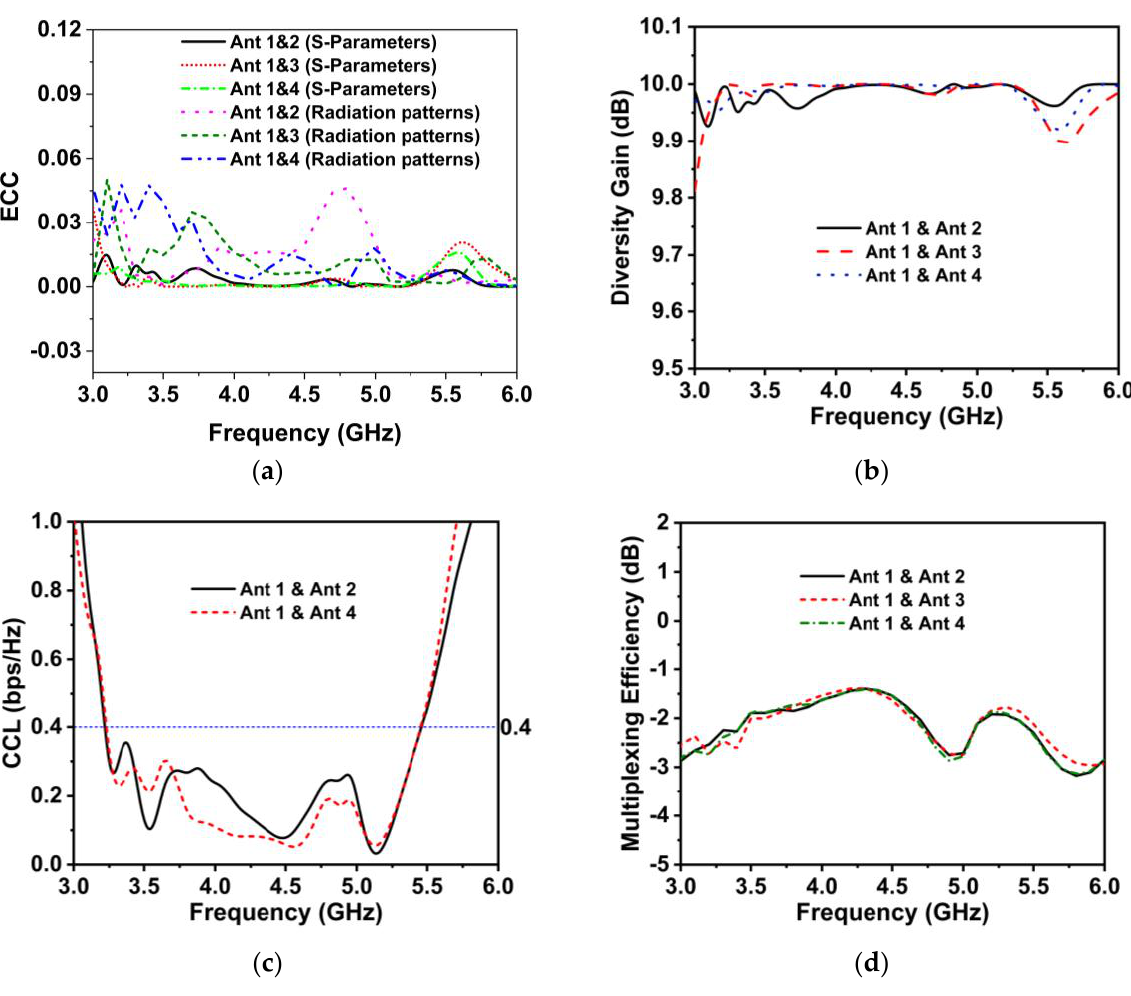
Figure 13. MM-based MIMO diversity characteristics ( a ) ECC, ( b ) DG, ( c ) CCL, and ( d ) ME.